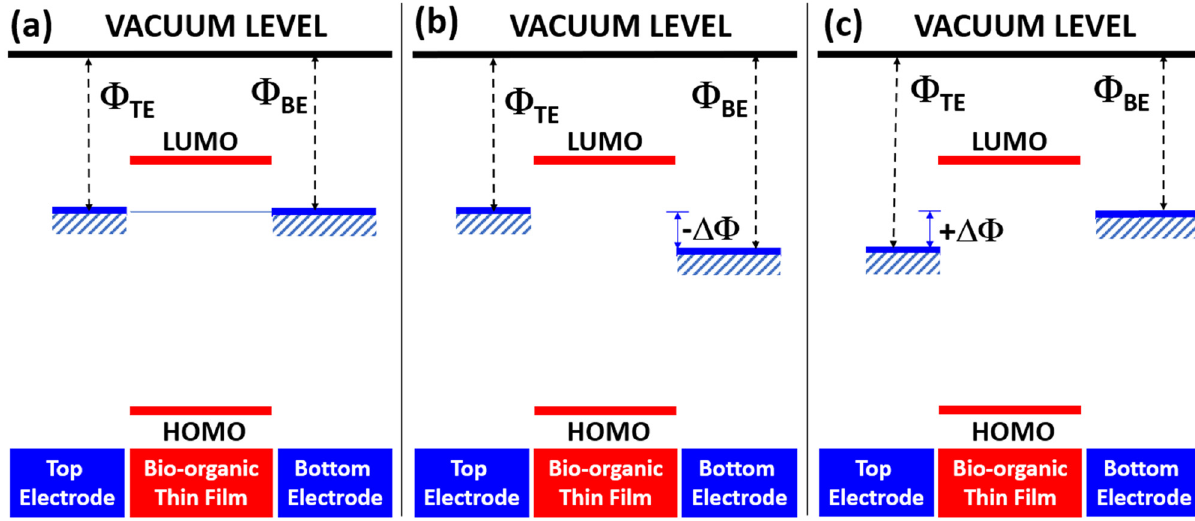
Figure 7: Illustration of the energy band diagram of three di ff erent scenarios with ( a ) zero, ( b ) negative, and ( c ) positive work function di ff erence ( ΔΦ ) between the top and bottom electrodes.